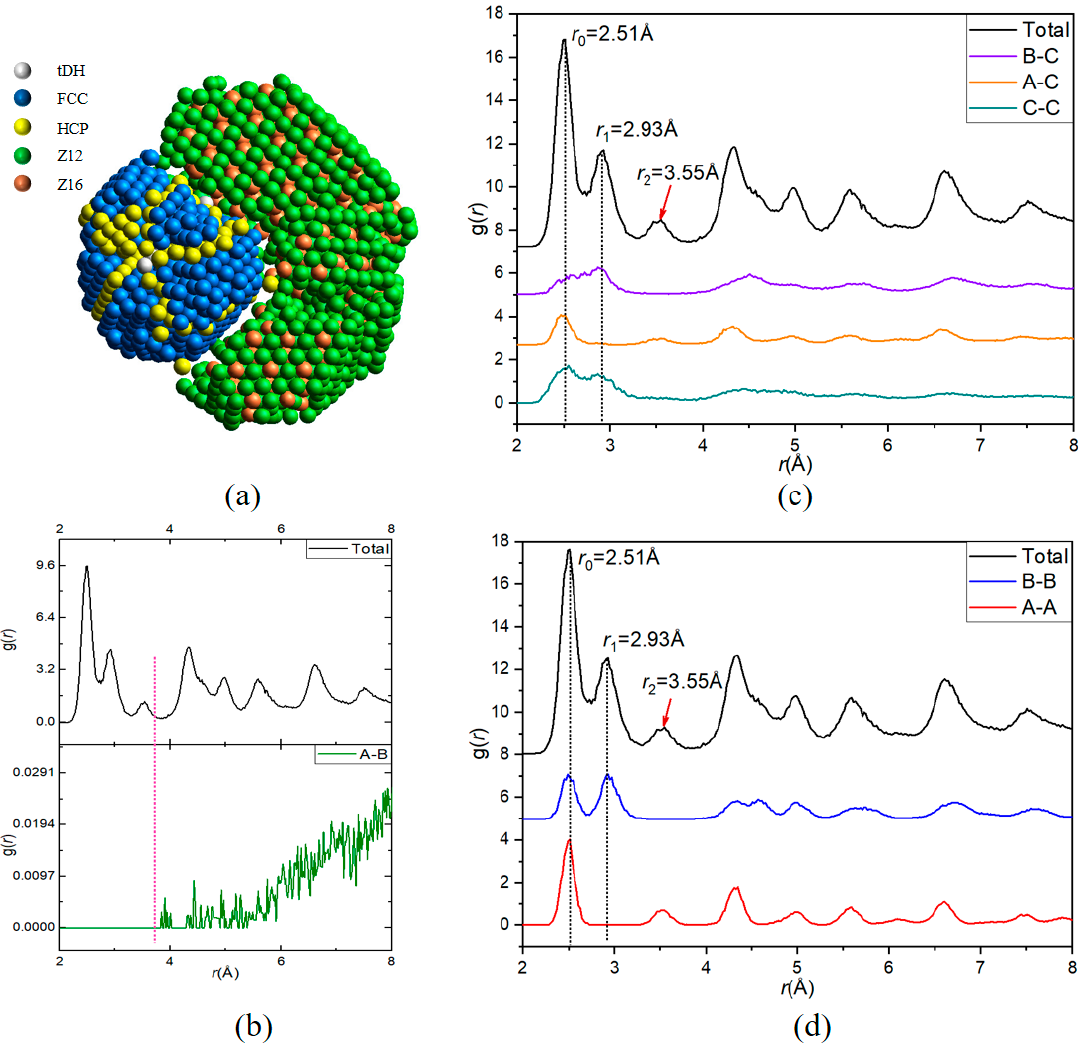
Figure 5. Illustration of partial PDF curves based on a ternary mode with a Ni 70 Ag 30 nanoparticle. ( a ) The 3D view for FCC, HCP, tDH, Z12, and Z16 atoms color-coded by LaSC type. ( b – d ) The correspondence between the total and six partial PDF curves, grouped by the magnitude of curves.